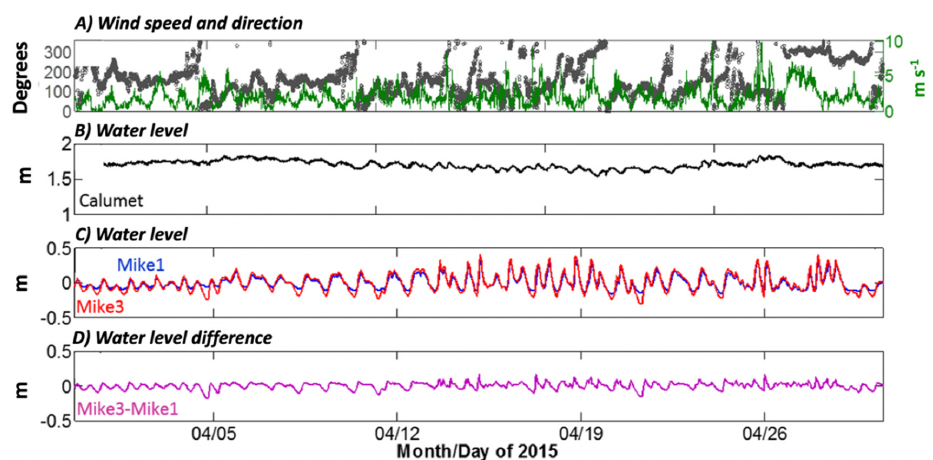
Figure 3. Wind, relative water level, and water level difference measurements ( A – D ) from the April 2015 instrument deployment at Mike1 and Mike3. Note the increase in wind speed and relative water level towards the end of April. The Calumet discharge station ( B ) is located ~20 km upstream of Mike Island (29°41 ′ 52 ″ N, 91°22 ′ 22 ″ W). Wind speed and direction data were downloaded from NOAA’s National Data Buoy Center station, located at Amerada Pass on Atchafalaya Delta (see methods). Wave, current velocity, and turbidity parameters were measured at Mike1 and Mike3 during both deployments. During the spring deployment, significant wave height at Mike1 was usually < 1 cm, with a few small peaks in wave height up to 4.24 cm (Figure 4A); average and standard deviation of wave heights during spring at Mike1 were 0.37 and 0.32 cm, respectively. Wave heights at Mike3 were generally higher than in Mike1, with wave heights primarily between 0 and 4 cm. During some storm events in late April 2015, wave height reached 24.67 cm, the highest waves measured during all sampling periods (Figure 4A); the average and standard deviation of wave heights during spring at Mike3 were 0.79 and 1.67 cm, respectively. Average current speed at Mike1 was 23 cm/s with significant fluctuations (Figure 4B). Due to instrument battery failure (ADV Ocean), no current data were collected at Mike3. Using an OBS, a proxy of turbidity (in nephelometric turbidity unit-NTU) was measured at Mike1 and Mike3. At Mike1, turbidity remained relatively low until a storm impact